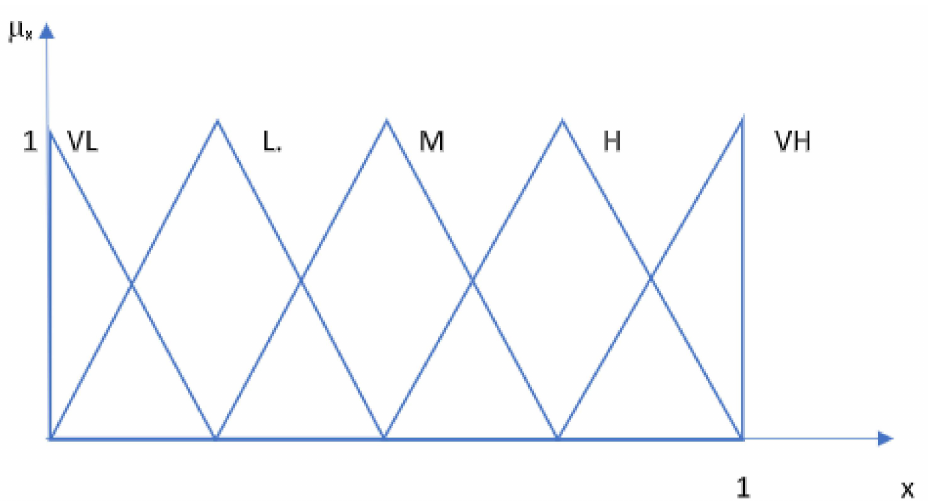
Figure 3. The triangular linguistic sets were used for the fuzzification process of the dataset. (Very high: VH, high: H, medium: M, low: L, very low: VL, µ x : membership values of the x values assigned to linguistic classes). Table 1. Fuzzy linguistic scale and the importance levels of the selected parameters. Linguistic/Triangular Fuzzy